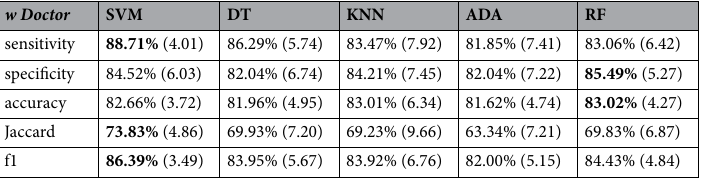
Table 5. Metrics scores achieved on selected feature subsets including expert’s verdict. STD is included in parentheses. Significant values are in bold.